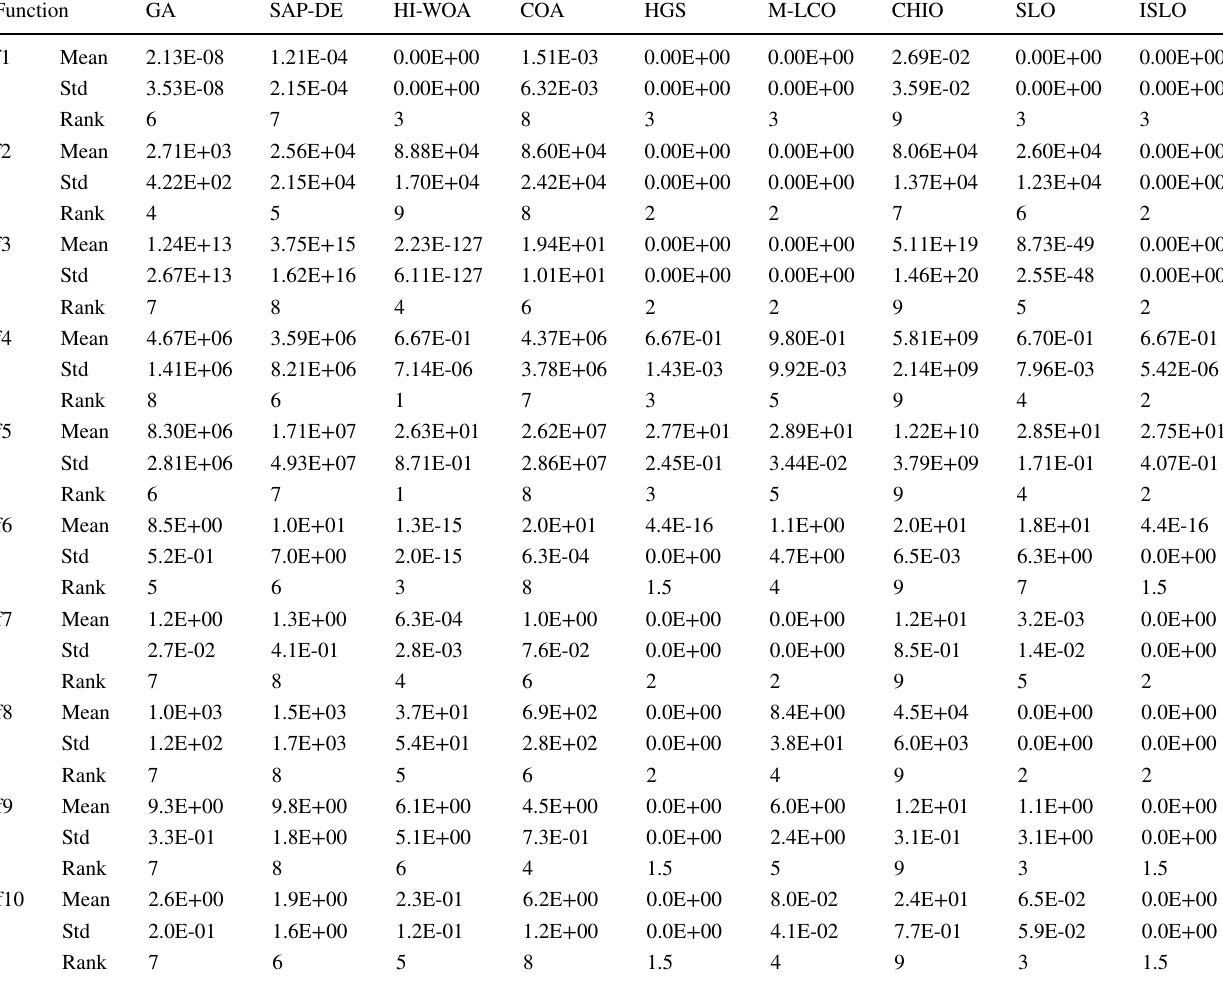
Table 2 Comparison of optimization results obtained for unimodal functions (f1–f5) and multimodal functions (f6–f10)